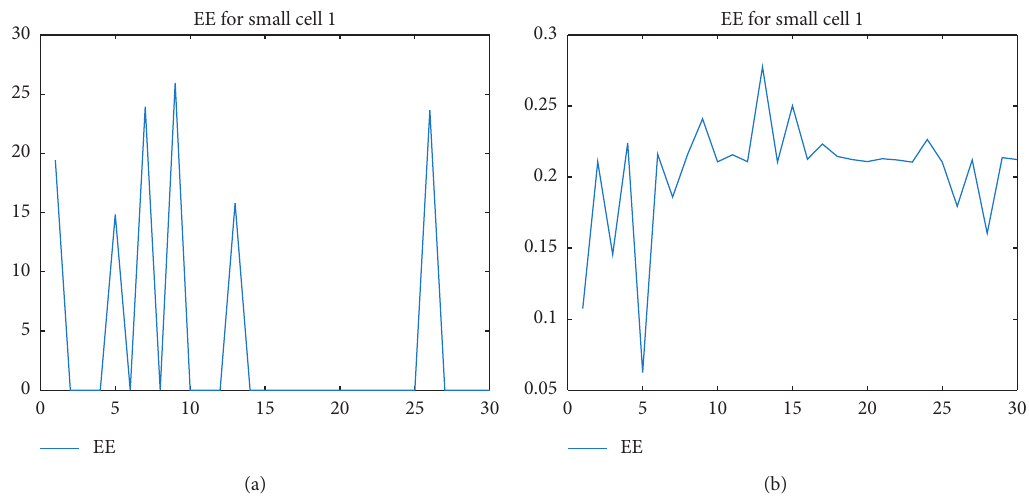
Figure 3: The energy efficiency (a) and SINR (b) of small BS 1 for 30